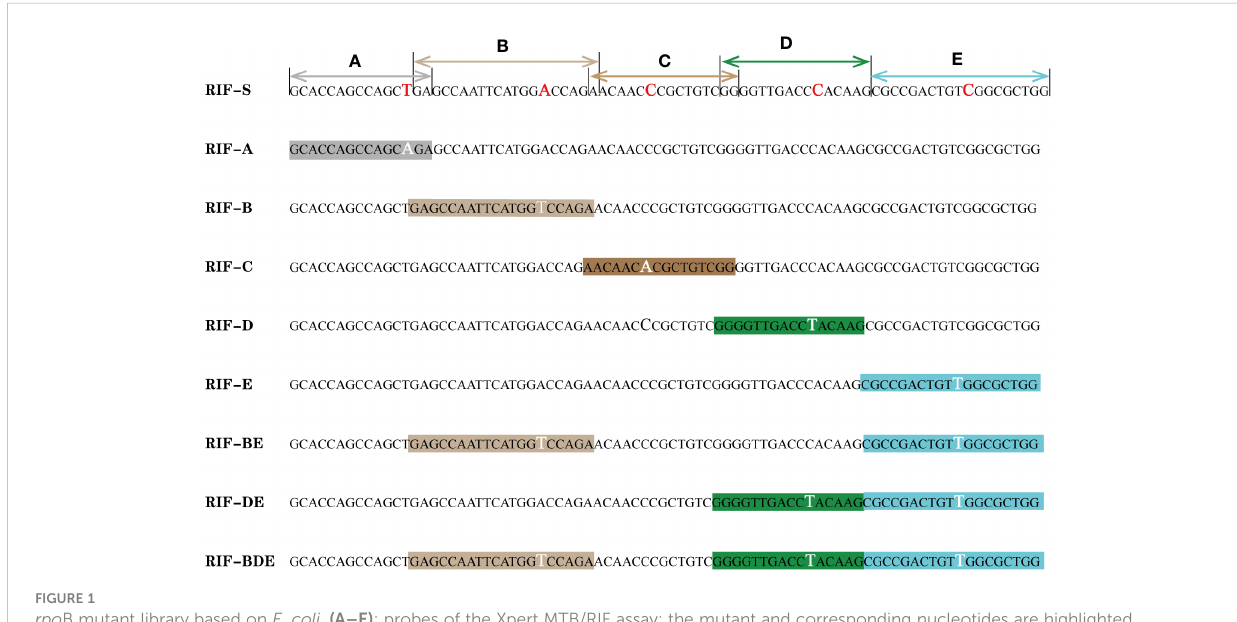
FIGURE 1 rpo B mutant library based on E. coli . (A – E) : probes of the Xpert MTB/RIF assay; the mutant and corresponding nucleotides are